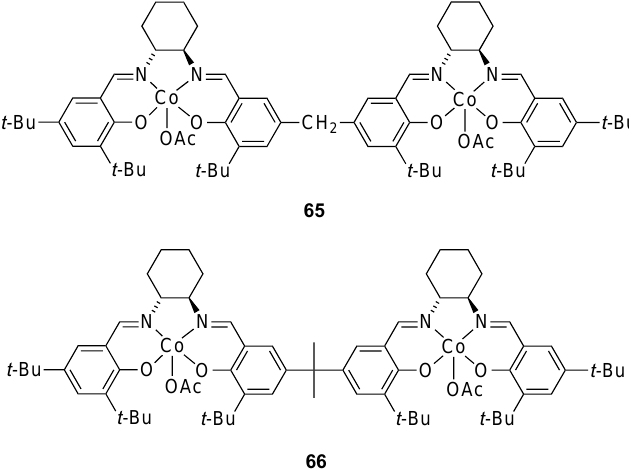
Figure 27. Dimeric Co(III)salen complexes 65 and 66 .